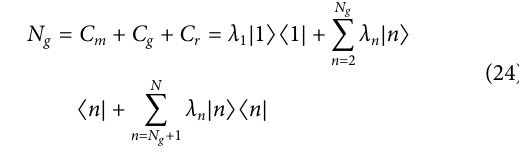
Frontiers in Physics |